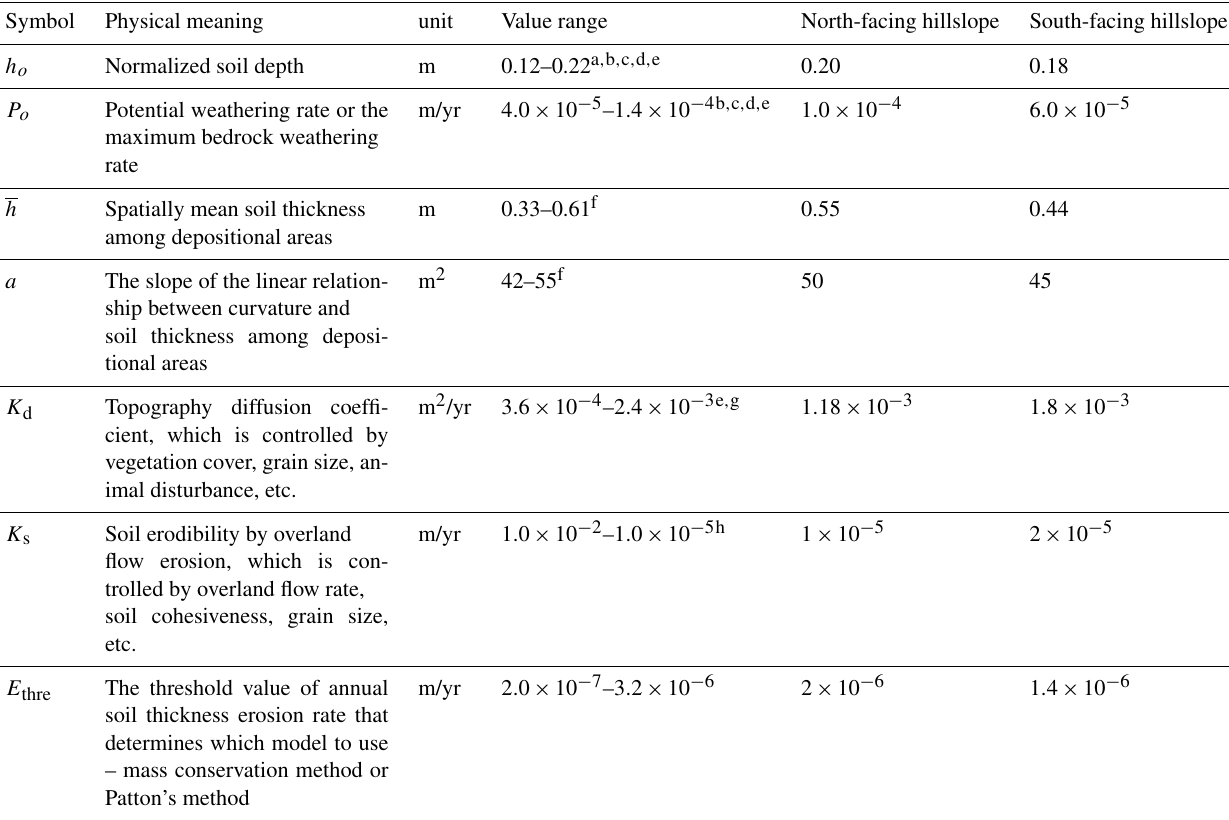
Table 1. Parameters used for fitting models of north-facing and south-facing hillslopes. Symbol Physical meaning unit Value range North-facing hillslope South-facing hillslope h o Normalized soil depth P o Potential weathering rate or the maximum bedrock weathering Spatially mean soil